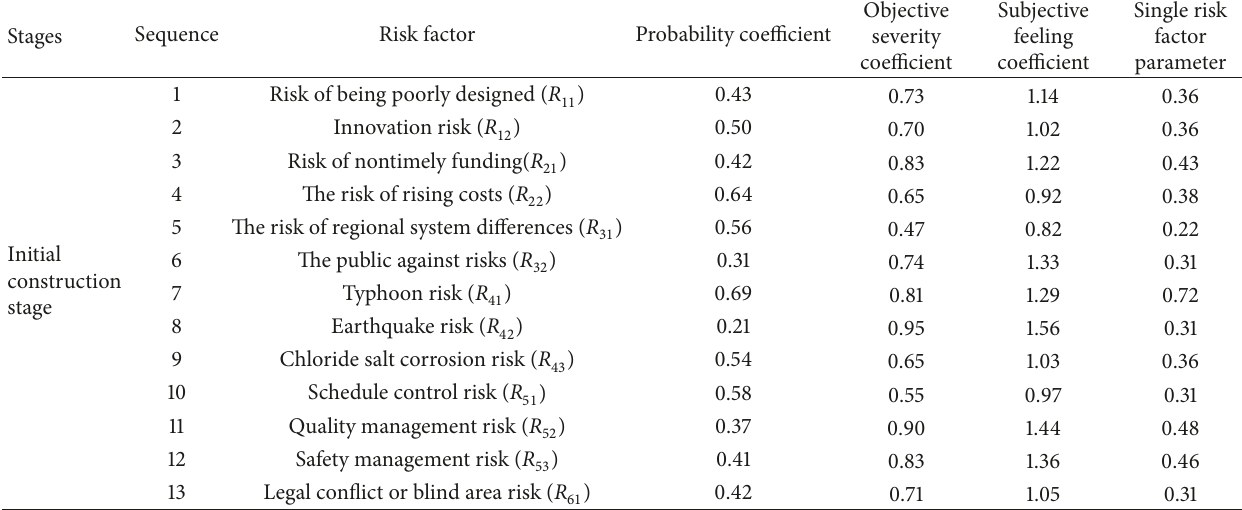
Table 9: Single risk factor parameter and coefficient of the HZMB in initial construction stage.